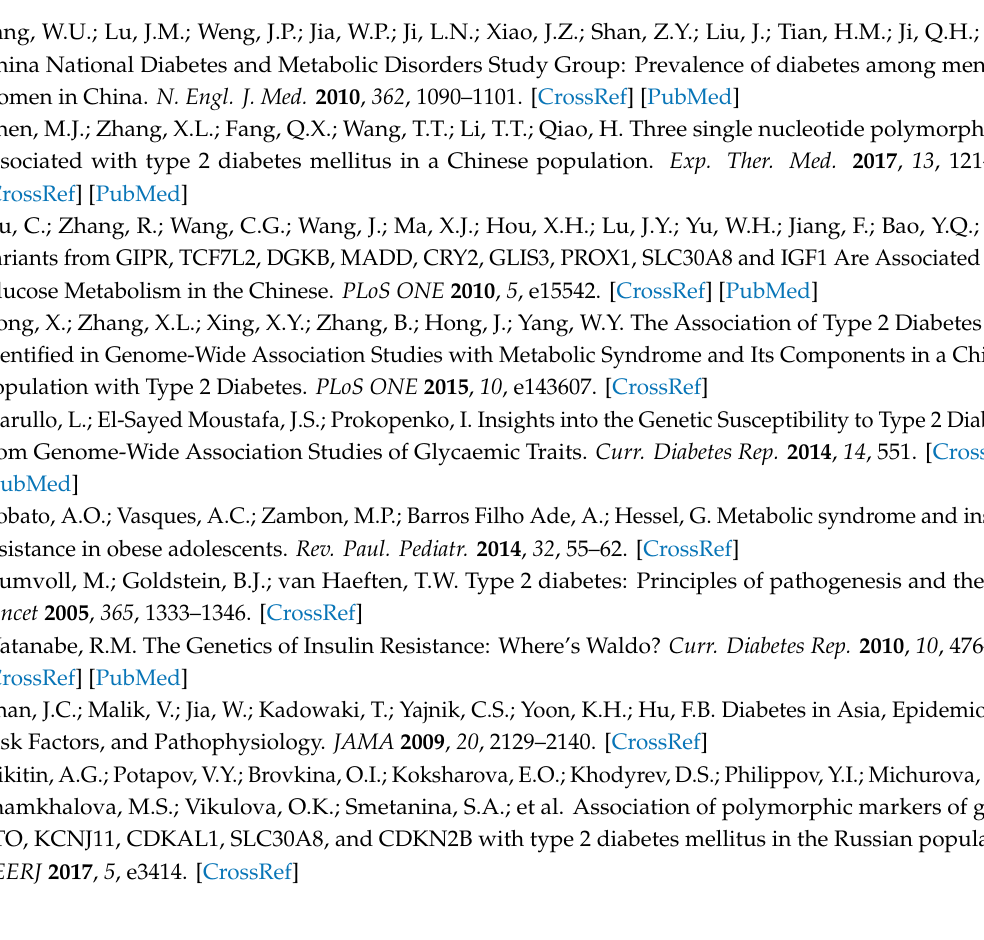
Table S1: Hardy–Weinberg equilibrium test of T2D-associated loci, Table S2: Overview of investigated genetic variants associated with insulin resistance, Table S3: Overview of investigated genetic variants associated with insulin